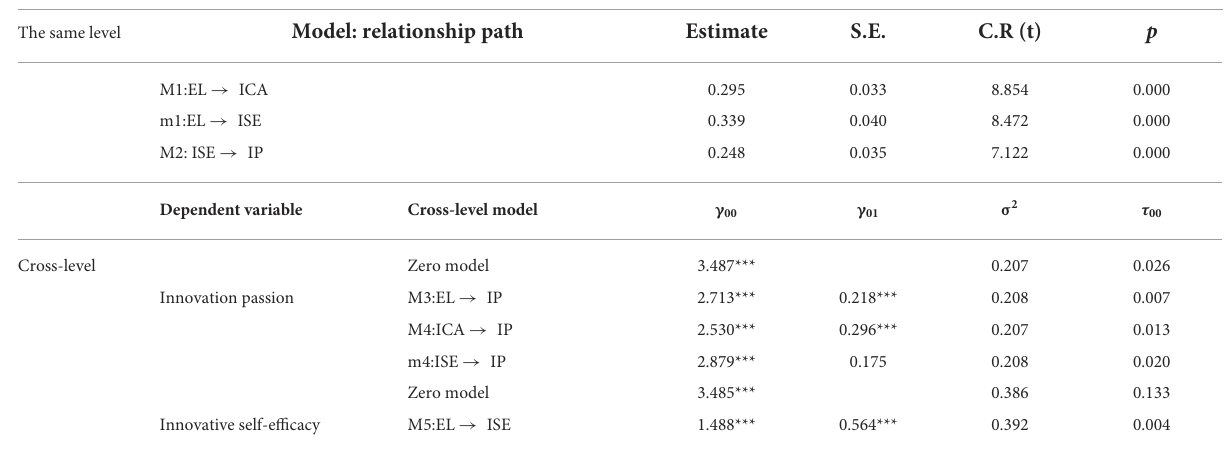
TABLE 4 Total effect hypothesis